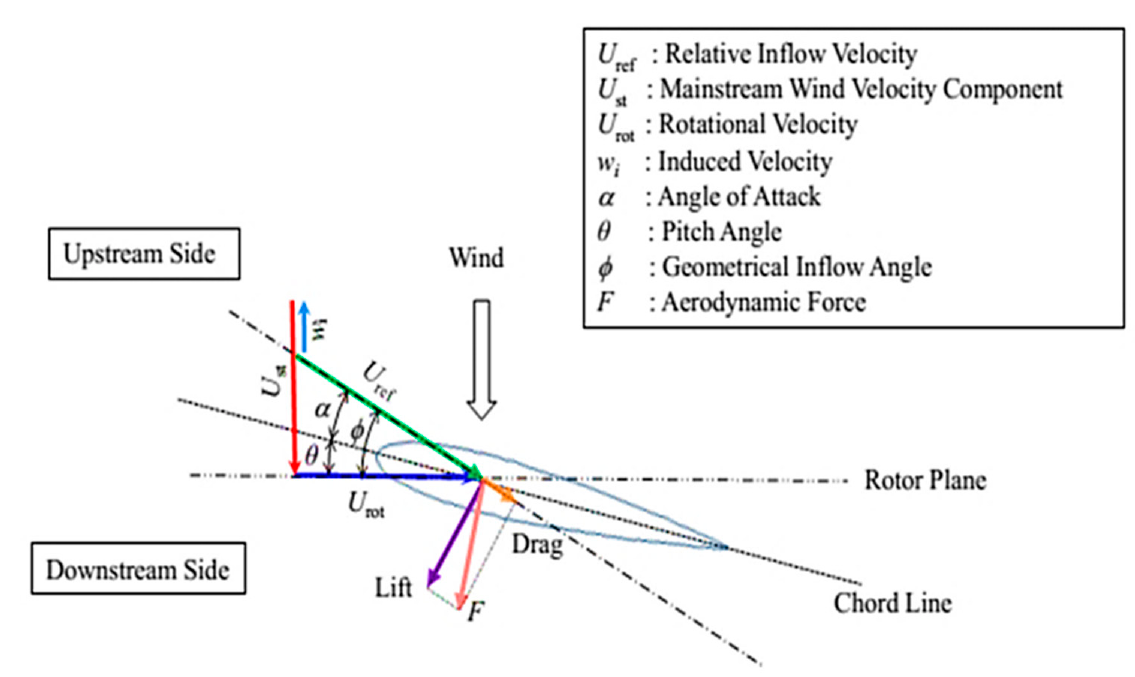
Figure 4. Flow force on blade element with the positive pitch angle.